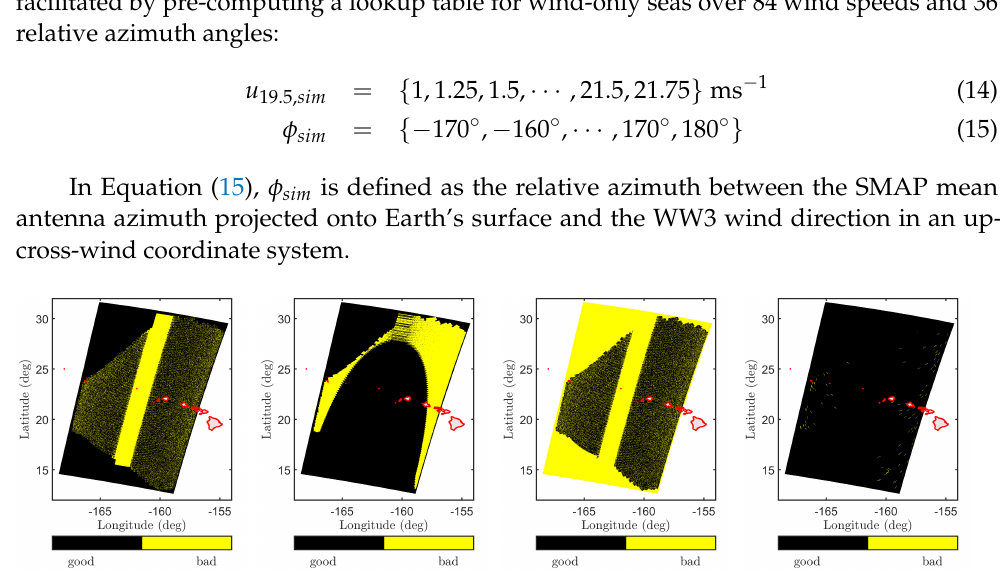
Figure 7. SMAP L1-C quality flags for orbit 01318D on 1 May 2015 over Hawaii. Figures from ( left ) to ( right ) show K p noise, Faraday correction, look-quality, and presence of RFI. In each figure, the black region identifies high-fidelity data, while the yellow region identifies poor quality data. The overall quality mask is a combination of these and other quality flags. See [47] for additional details.